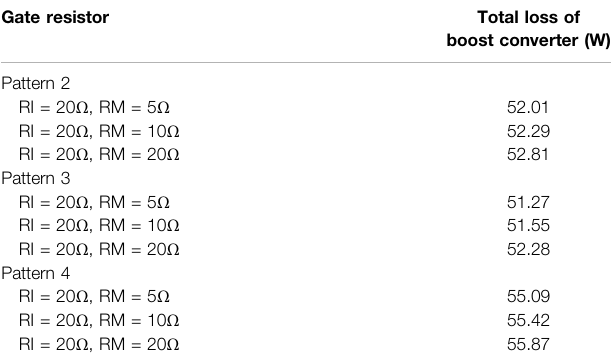
TABLE3| Relationshipbetweenthegateresistorandtotallossofboostconverter (changing gate resistor of SiC MOSFET). Gate